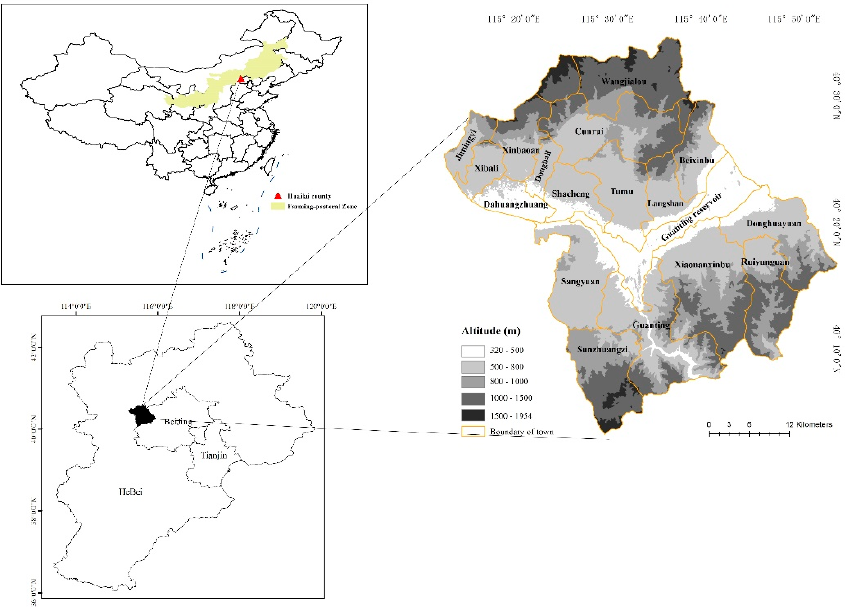
Figure 2. Geographical location and altitude of Huailai County.